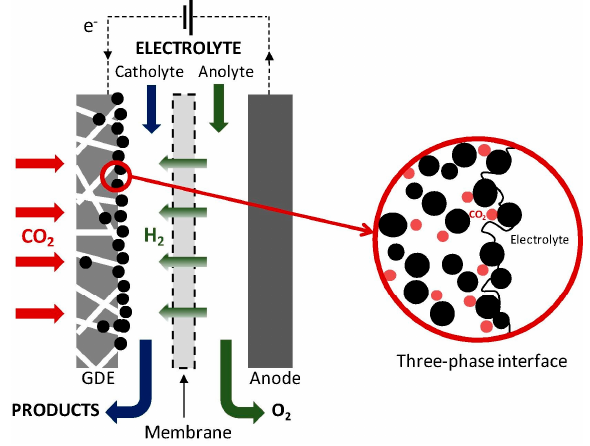
Figure 3. Representation diagram of the electrolytic cell configuration for the electroreduction of CO 2 supplied directly from the gas phase. In this study, the filter-press electrochemical system possesses three inputs (catholyte, anolyte, and CO 2 separately) and two outputs (catholyte–CO 2 and anolyte) for the electroreduction of CO 2 in gas phase. (Reprinted with permission from Ref. [82]. Copyright 2016 Elsevier).